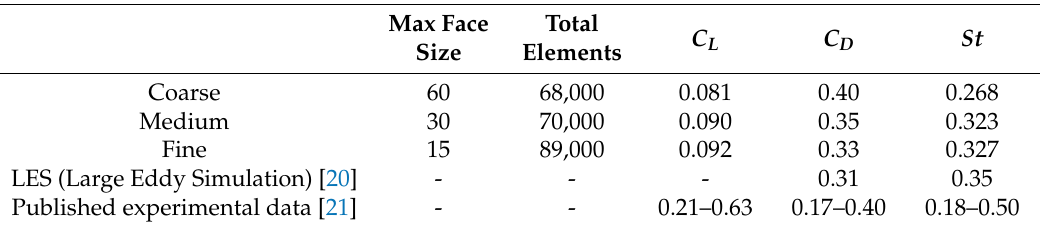
Table 1. Simulation validation ( C L and C D is the lift and drag coefficient on the cylinder, St is the corresponding Strouhal